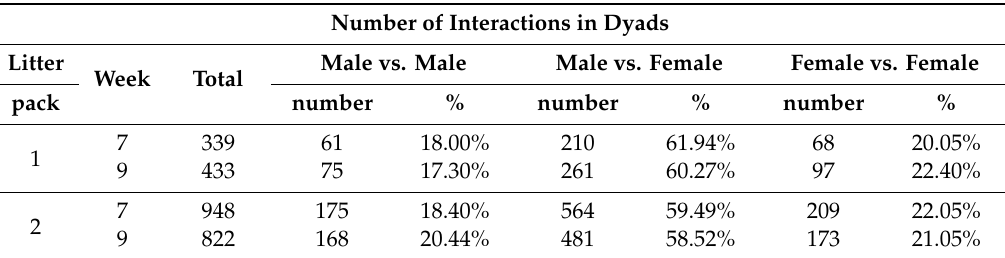
Table 3. Numbers of intrasexual and intersexual interactions in dyads in 7th and 9th week.